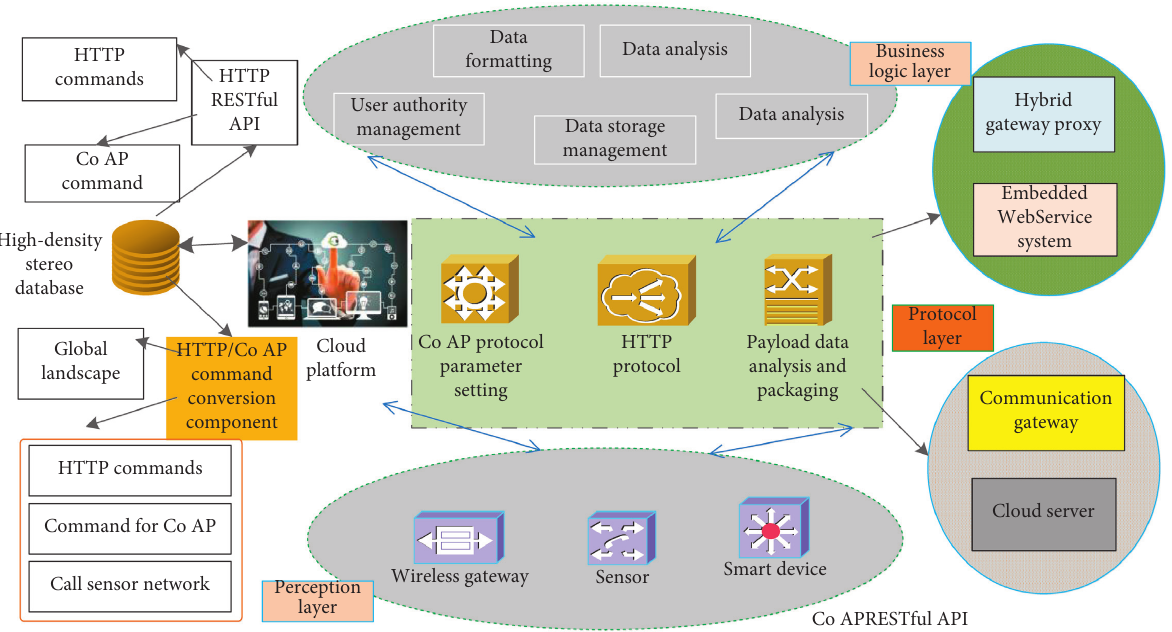
Figure 1: Schematic diagram of a high-density three-dimensional Internet of Things landscape service platform based on the Co AP